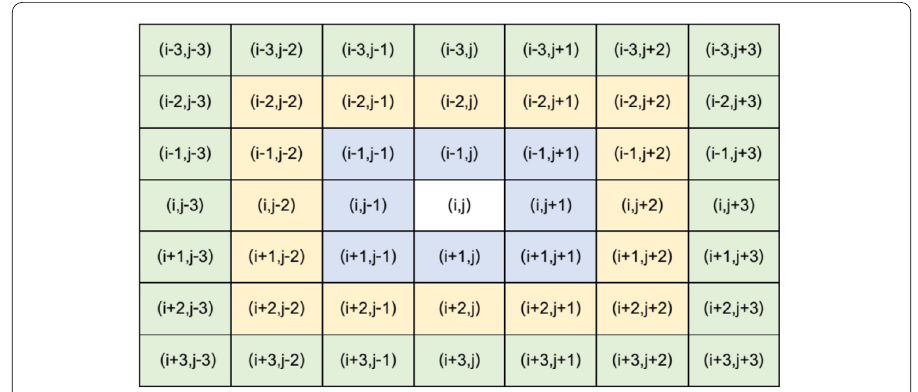
Figure 1 The blue, yellow, and green areas represent immediate neighborhood, distant neighborhood, and far distant neighborhood, respectively, of the cell ( i , j )